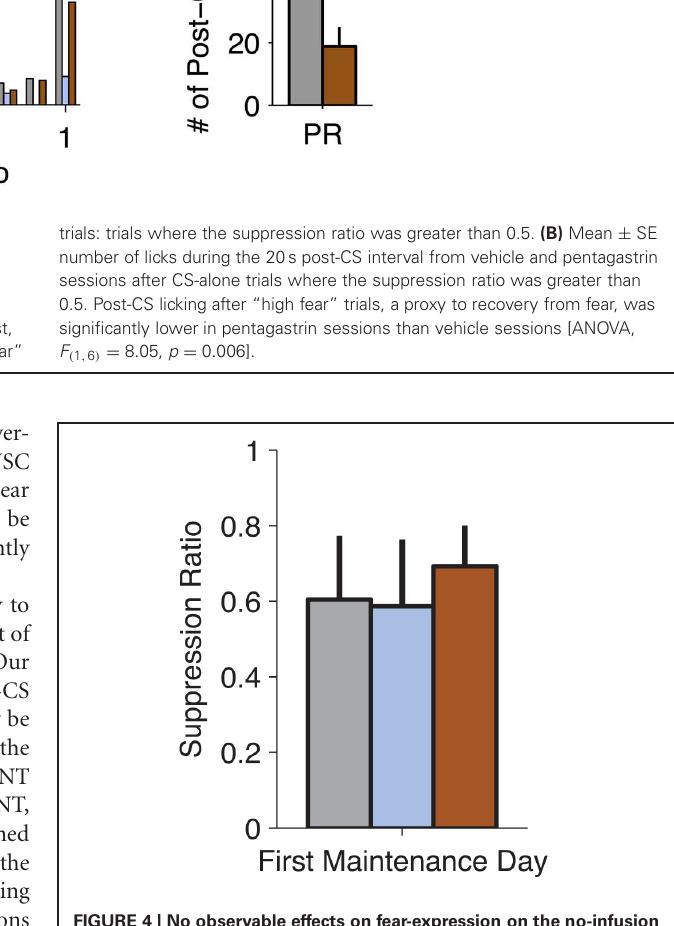
FIGURE 4 | No observable effects on fear-expression on the no-infusion day following drug treatment. We examined whether our pharmacological manipulations of the LA (on Thursdays) affected the following day of training (on Monday). Suppression Ratio on the first day following each manipulation was not significantly different (ANOVA, p > 0 . 8) suggesting that the drug treatments did not affect the reconsolidation of the